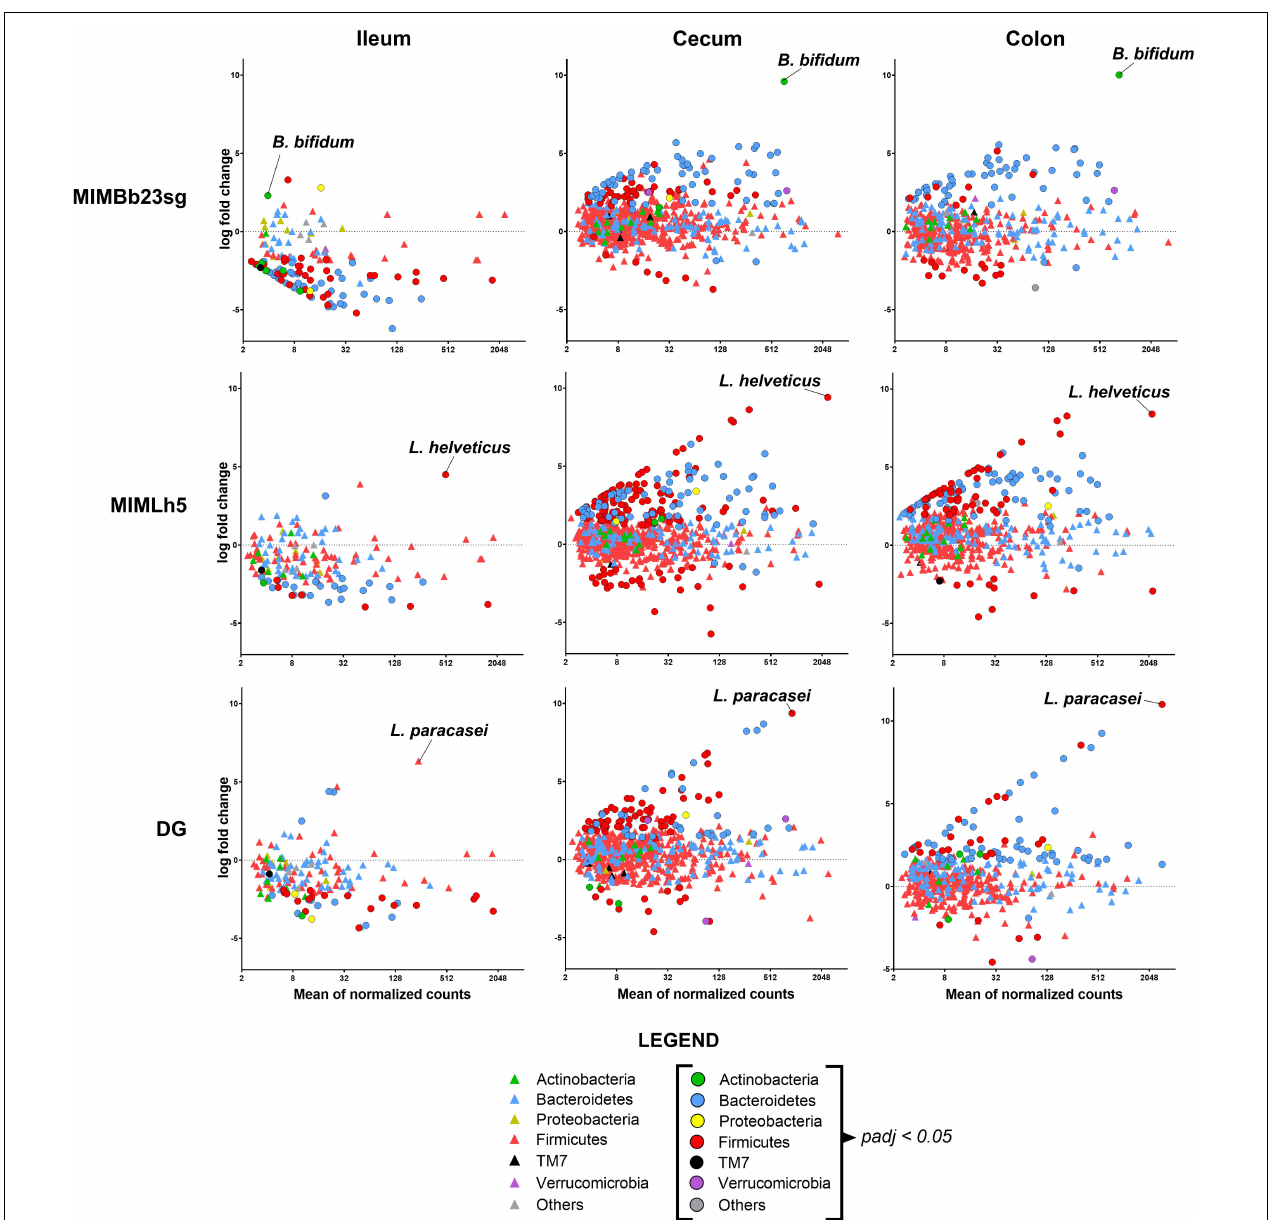
FIGURE 3 | Differences in microbiota composition between PBS-treated mice and the three groups of mice gavaged with a probiotic strain in the different intestinal sites. Each symbol (circle or triangle) refers to a single OTU. Symbols’ color indicates OTU’s phylum, as described in the legend. OTUs with a significantly different abundance between groups (i.e., padj < 0.05) are indicated with